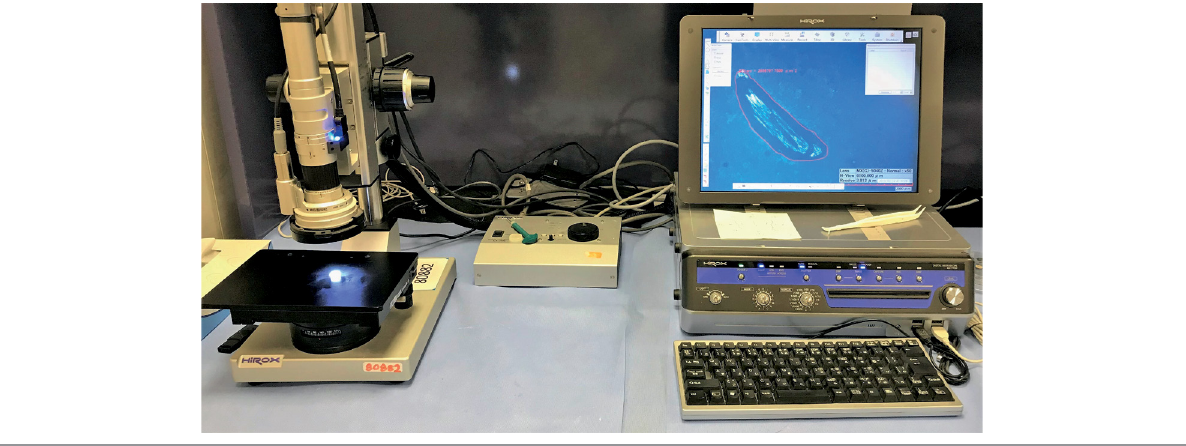
Figure 3. Digital microscope (HIROX, KH-7700) with mounted specimen for scanning.